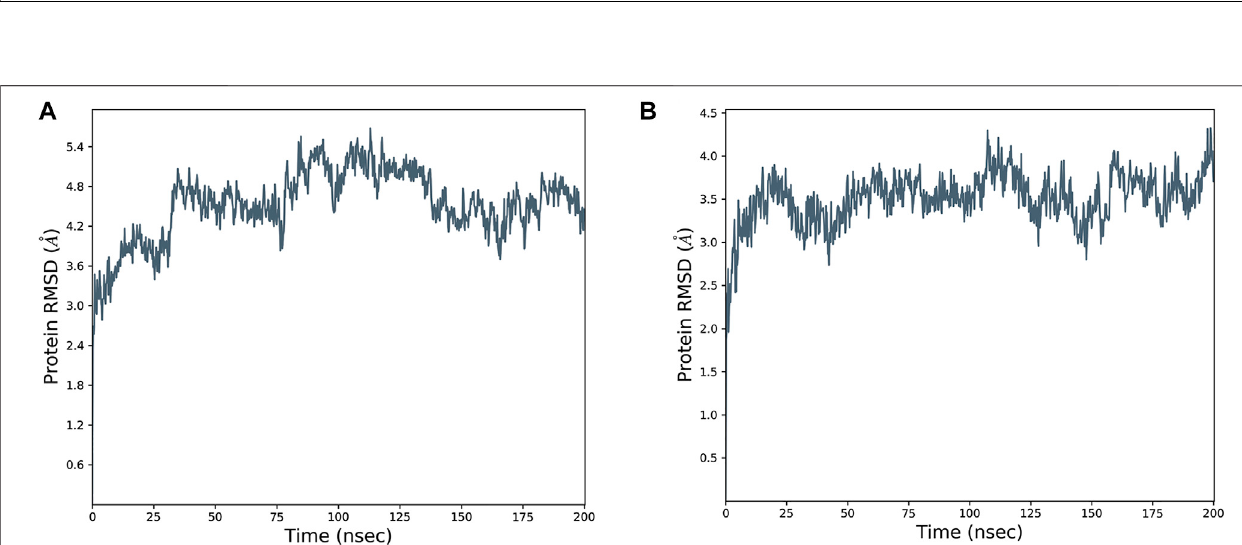
Frontiers in Genetics |